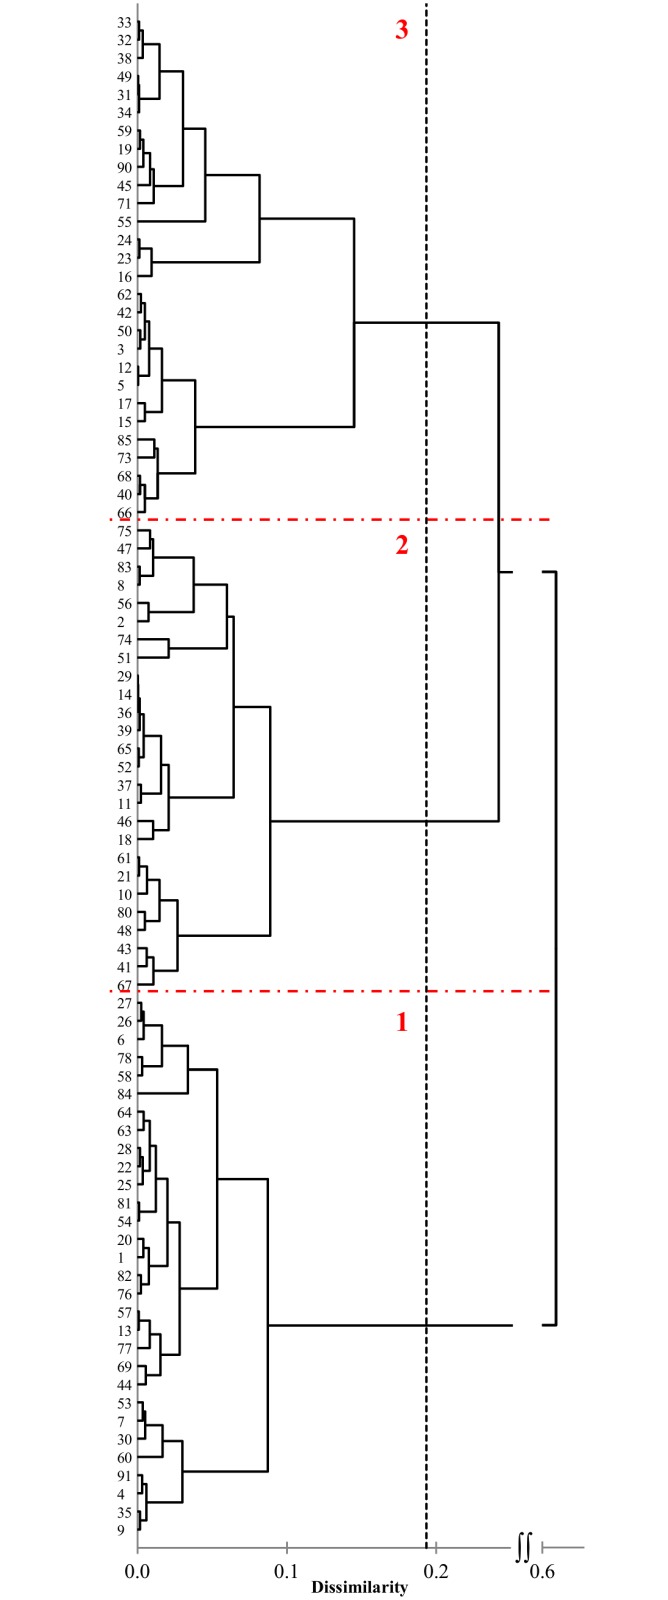
Dendrogram obtained from agro-morphological traits of 84 oat landraces using Ward’s algorithm with three major clusters marked by dashed line.